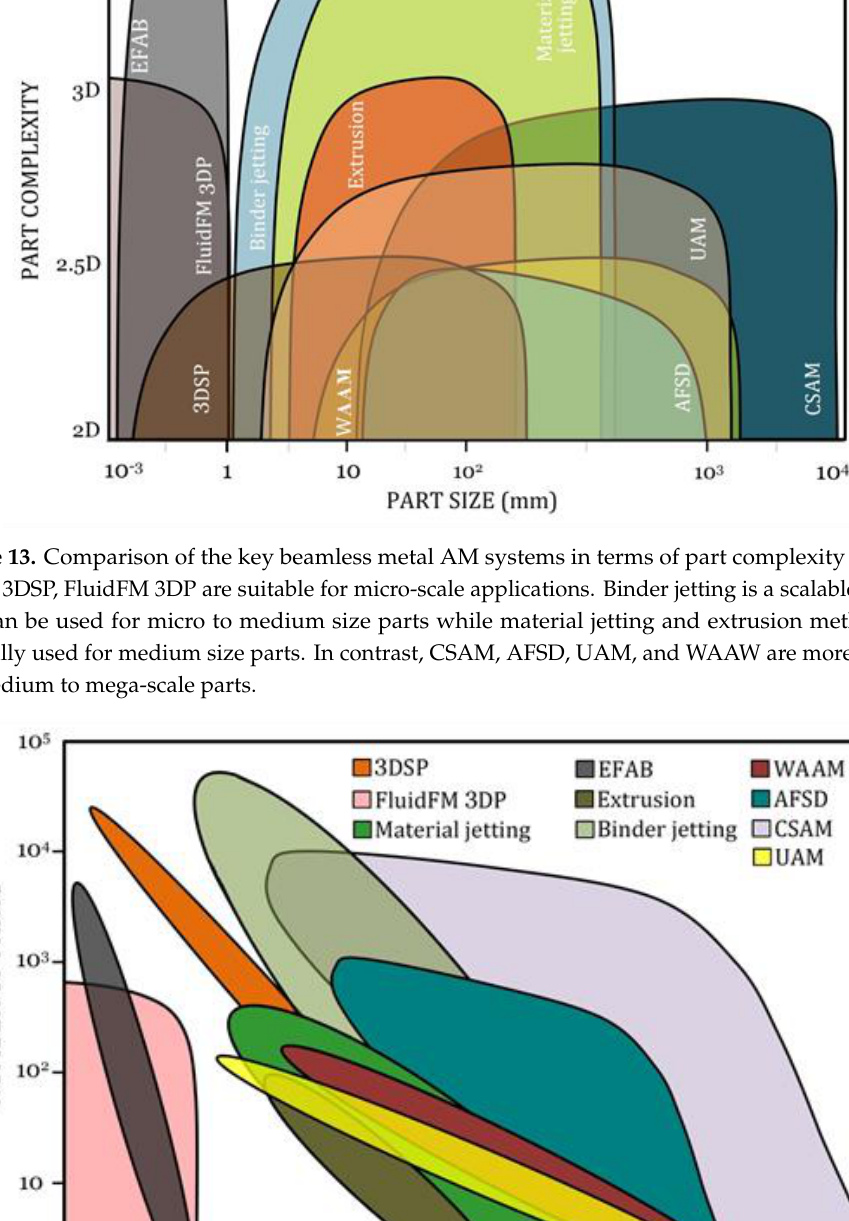
Figure 15. Comparison of the key beamless metal AM systems in terms of part complexity and minimum feature size. Material jetting, binder jetting, and EFAB processes have the capability to print sophisticated 3D parts and assemblies. FluidFM 3DP, extrusion, and CSAM can be used for manufacturing of true 3D parts, while the other processes are normally served for parts with less complexity.